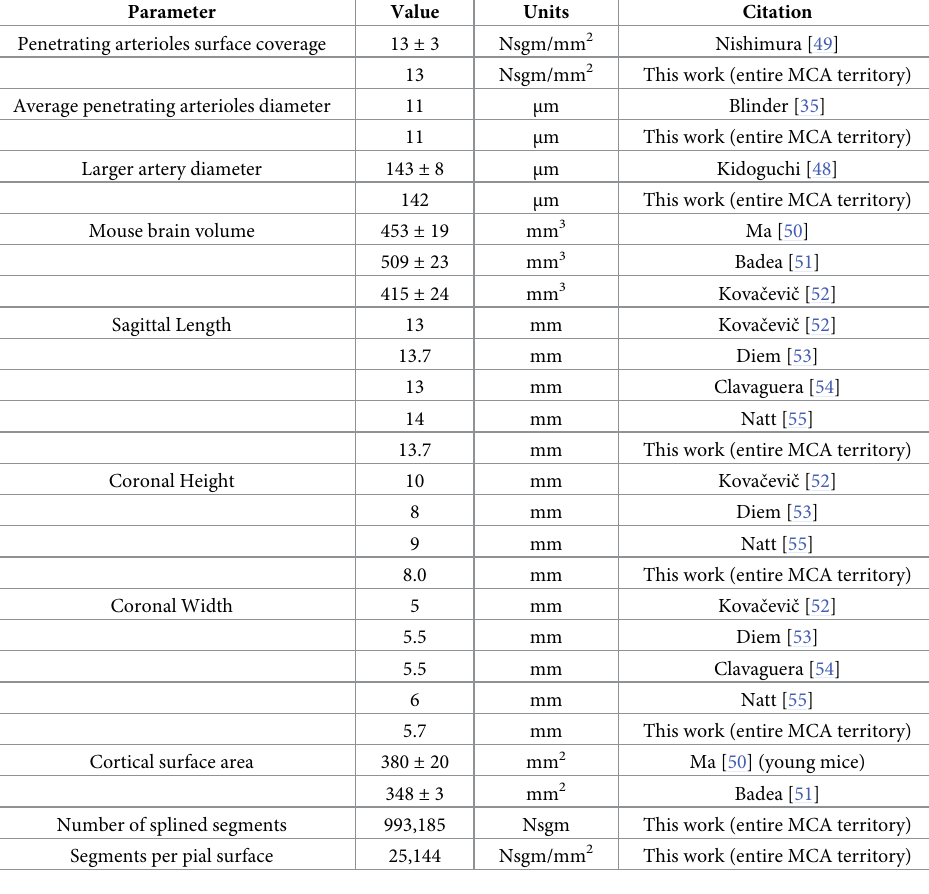
Table 2. Pial network parameters used in this work in comparison to prior research.